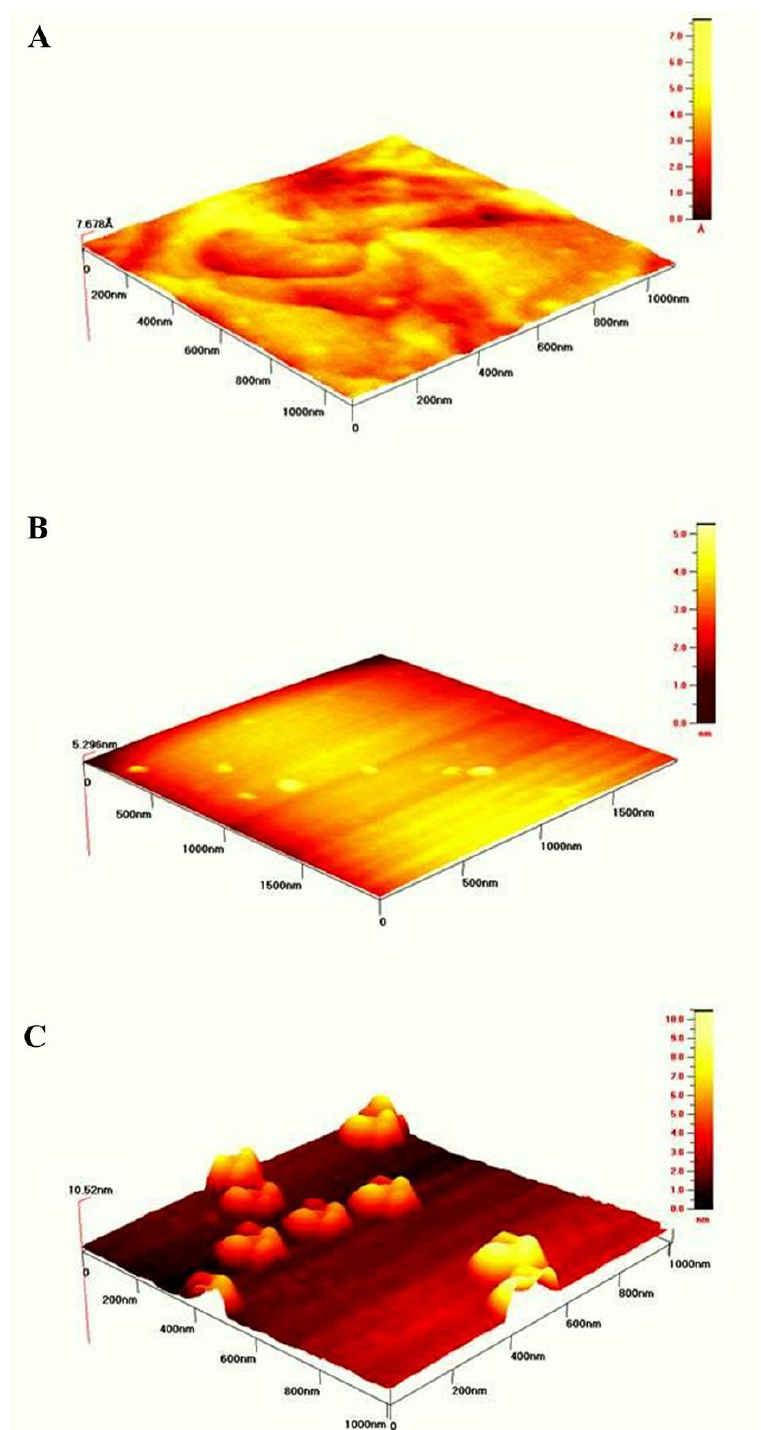
Figure 5. AFM images of: ( A ) gold Au(111) thin films on mica substrate, ( B ) NAC/DPTA SAM, ( C ) NAC/DPTA–Cu(II)–His –RAGE V natural 6